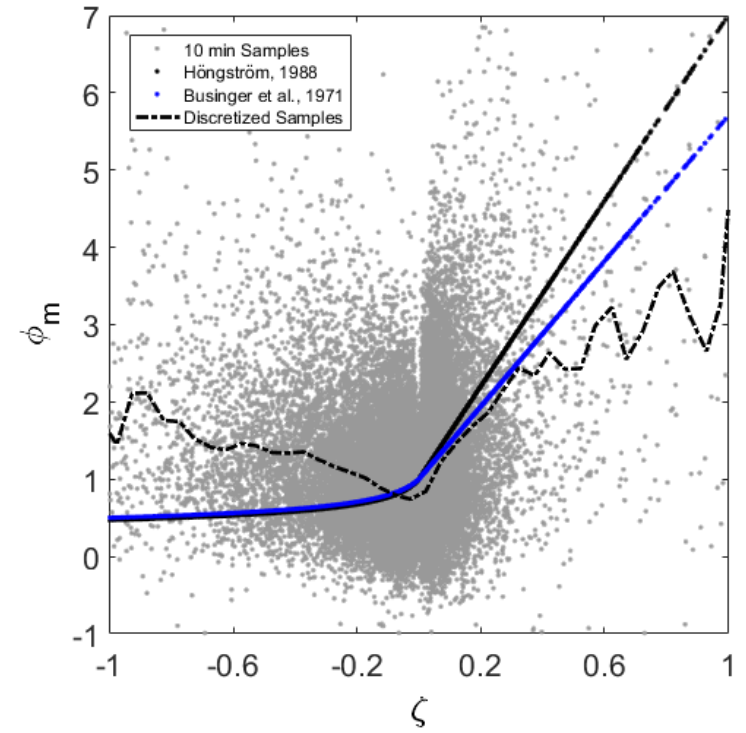
Figure 6. ϕ m and ζ relation with a comparison of theoretical